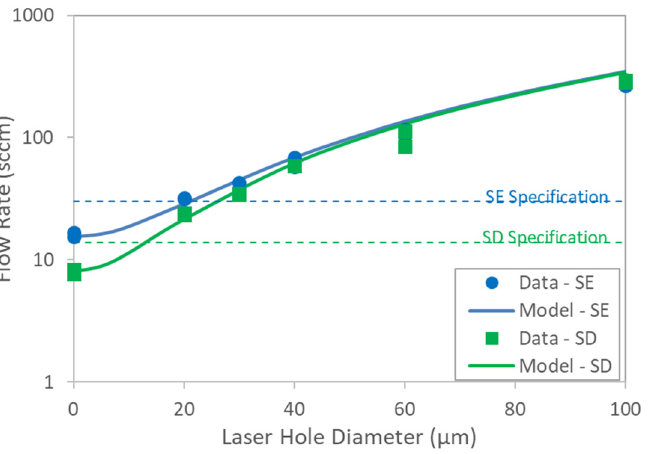
Figure 7. Flow rate of 40 psi (276 KPa) through SE- and SD-type filters as a function of laser hole diameter. Diffusion specifications indicated in plot are from filter vendors.